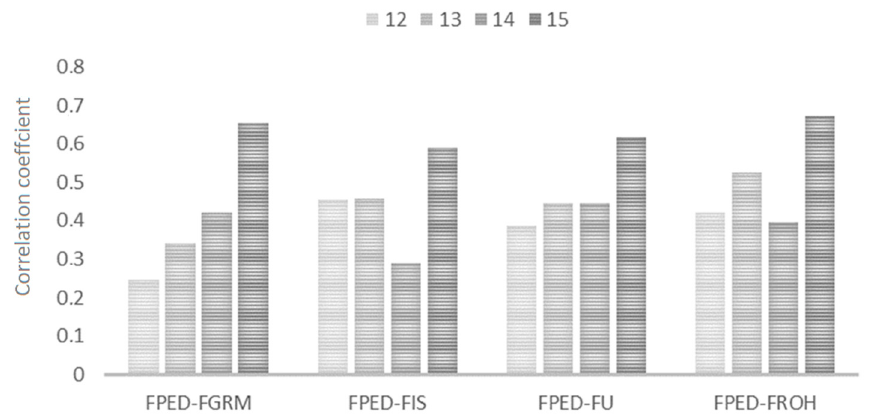
Figure 6. Spearman’s rank correlation coefficients among F PED and genomic measures of inbreeding depending on the number of generations registered in the pedigree. Table 5. Basic statistics for Q ‐ value from Admixture software and linage data from pedigree.